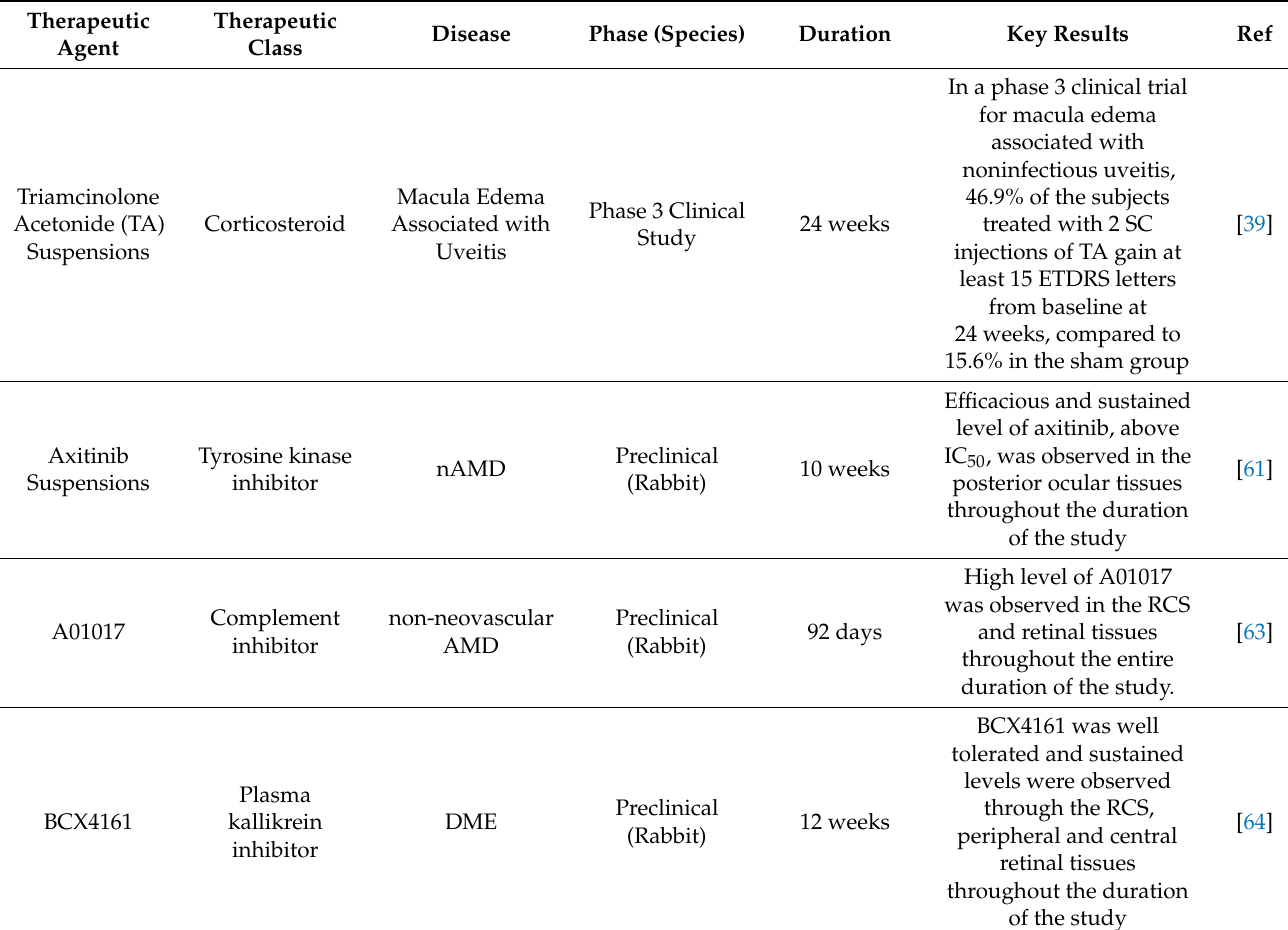
Table 1. Summary of Preclinical and Clinical Investigations of Small Molecule Suspensions Administered into the Supra- choroidal